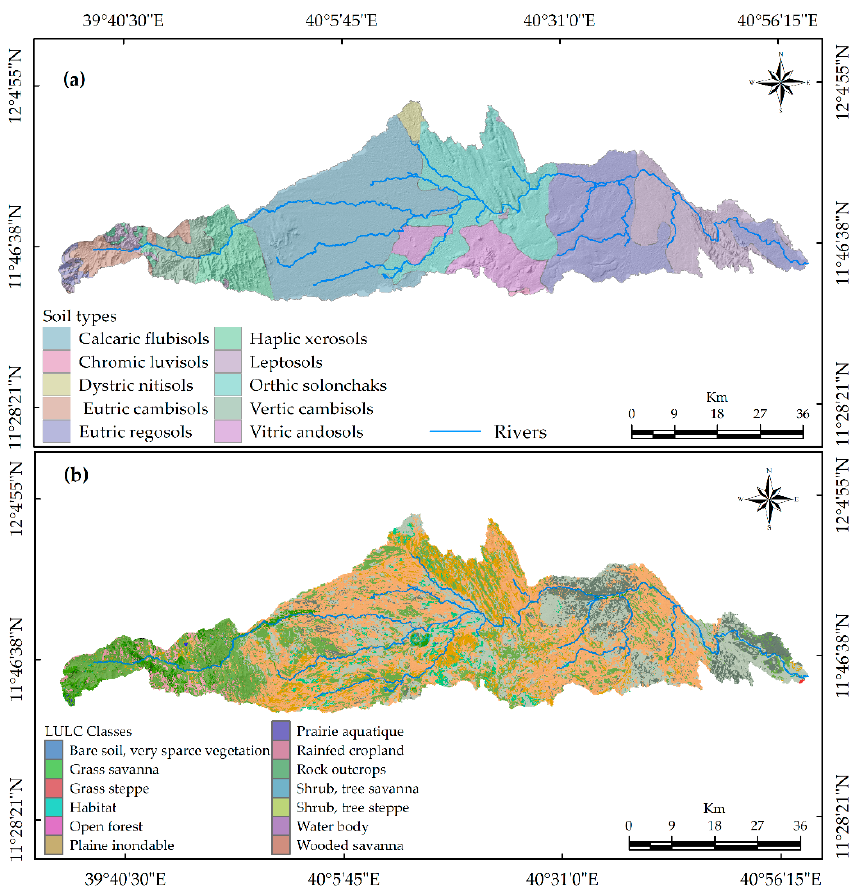
Figure 3. Soil types ( a ) and Land Use/Land Cover (LULC) classes ( b ) in Logiya watershed.